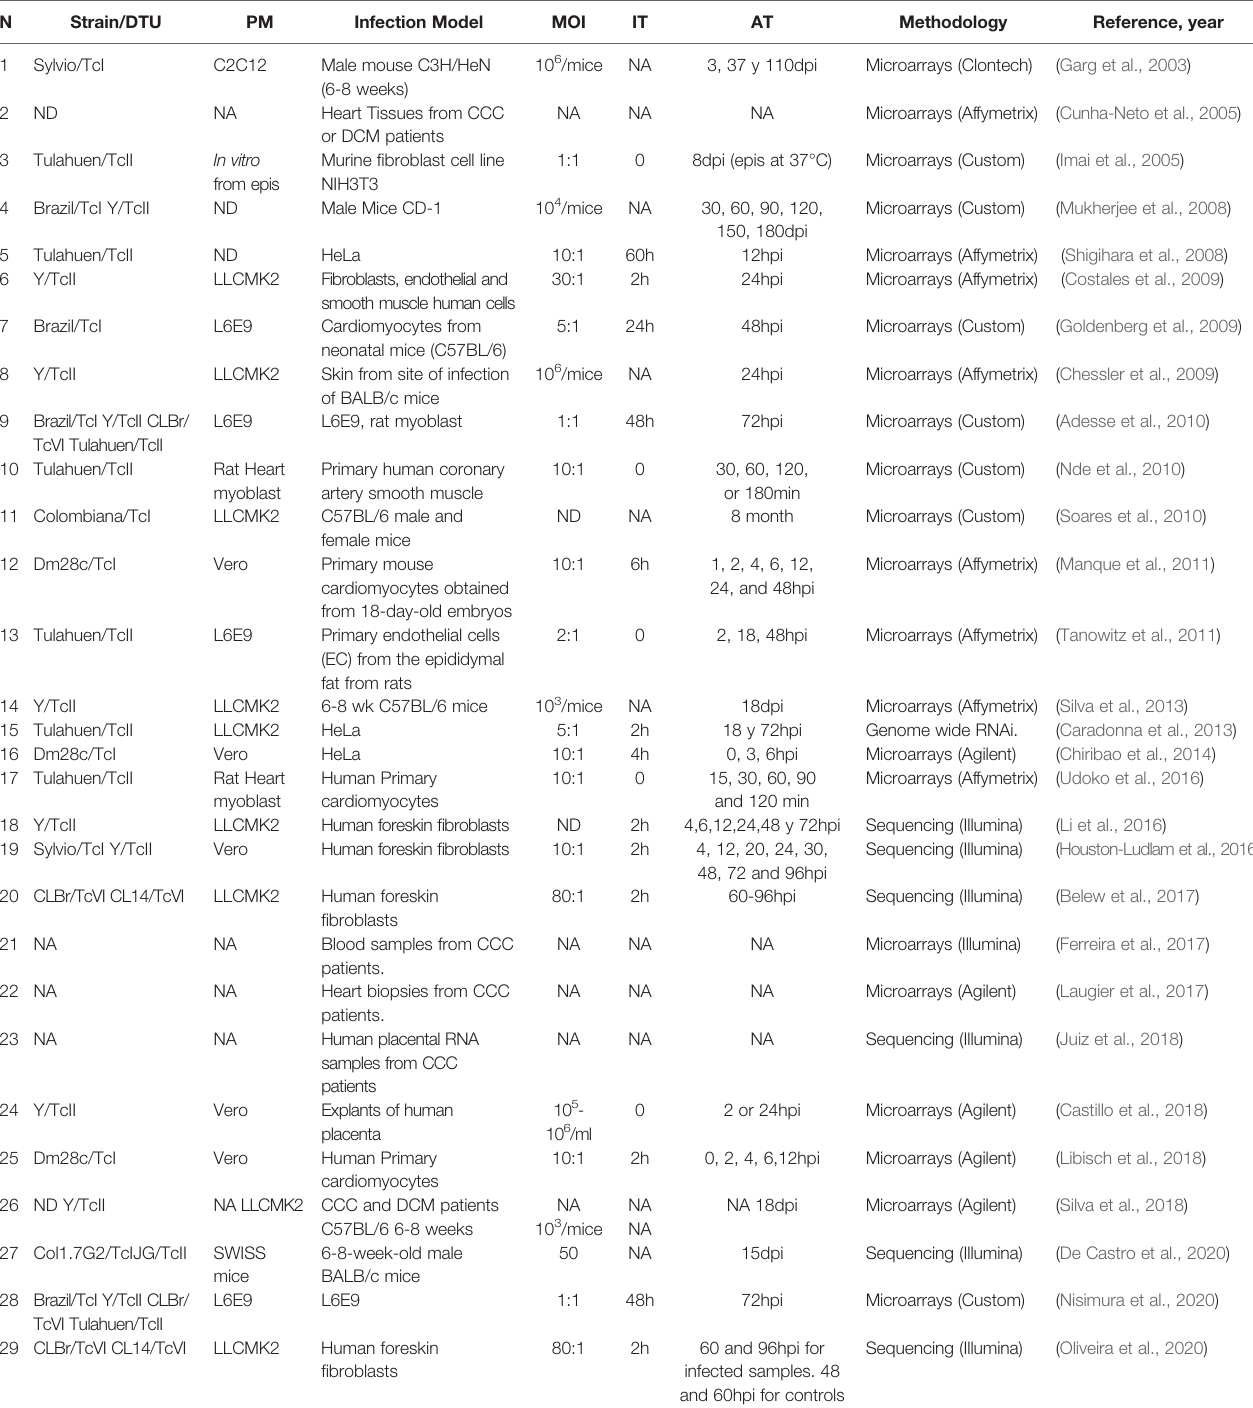
TABLE 1 | Different T. cruzi -host cell interaction studies incorporating transcriptomics of the infected host cell.